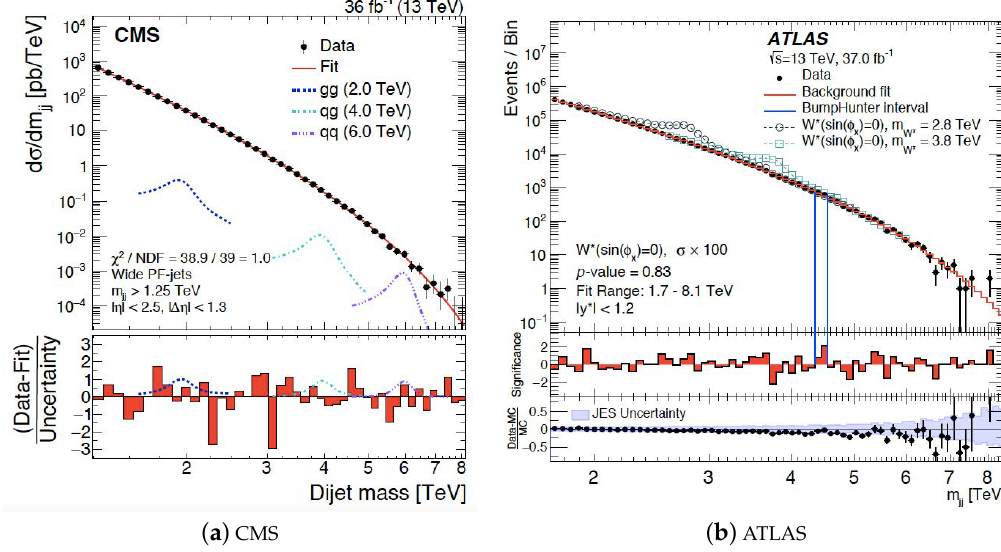
Figure 10. Di-jet invariant mass distributions for the CMS [22] ( a ) and the ATLAS [23] ( b ) analyses. The results are interpreted as upper limits on the quark-mediator coupling, as a function of the mediator mass, and are displayed in Figure 11. The most stringent limit is given by ATLAS, for m med = 1.5 TeV, and corresponds to g q = 0.08.